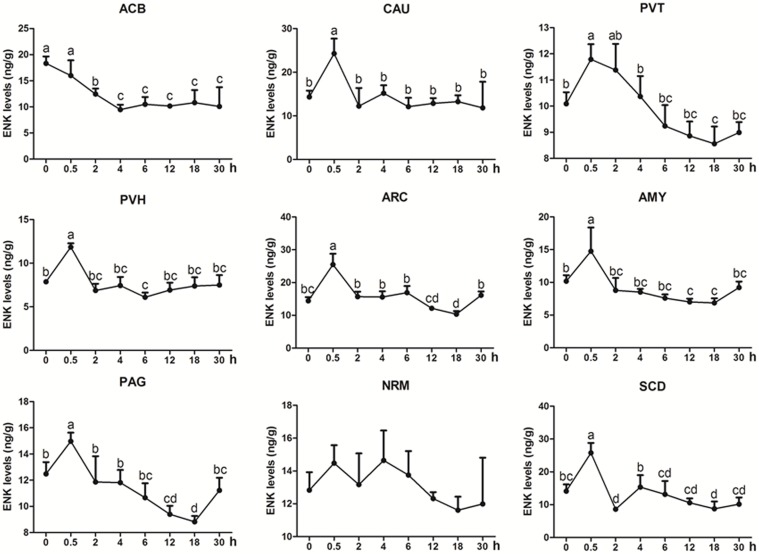
The effect of EA on ENK levels in the CNS of goats (mean ± SD, n = 6). ENK levels in the nucleus accumbens (ACB), the caudate nucleus (CAU), the paraventricular nucleus of the thalamus (PVT), the paraventricular nucleus of the hypothalamus (PVH), the arcuate nucleus (ARC), the amygdala (AMY), the periaqueductal gray (PAG), the nucleus raphe magnus (NRM), and the spinal cord dorsal horn (SCD). The values with different letters differ significantly (p < 0.05). One-way ANOVA followed by Bonferroni’s post-test.